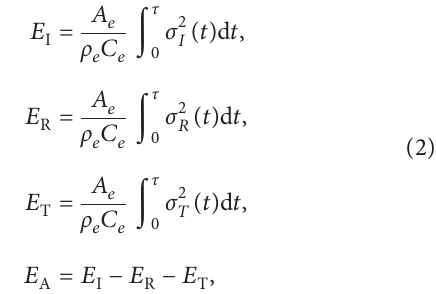
Note: “ e 1, e 2” denotes an obvious rise process as shown in its strain-time curves. The symbol “—” denotes a relatively low fluctuation of the strain- time curves, generally less than